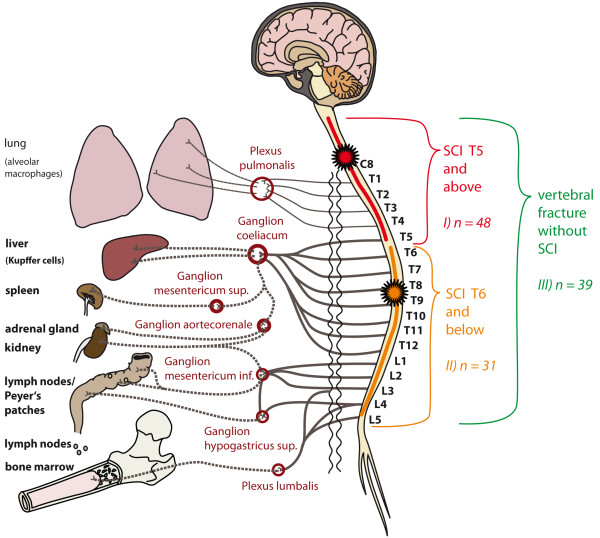
Relay-interaction of the immune system and the central nervous system. Legend: Groups for primary comparison in relation to the major sympathetic outflow (vegetative innervation). In Group I (SCI of the neurological level T4 or above) the lesion is localized within the spinal segments C2-T5, resulting in a disturbance of the sympathetic innervation of immunologically relevant organs through the coeliac ganglion and further ganglia connected through lower segments of the spinal cord. Of note, the neurological level is defined by the ISNCSCI as the most cranial segment with normal sensory function and a muscle grade of at least 3/5 with normal function in the segments above on both sides of the body, i.e. in case of a neurological level T4, the lesion begins in the segment T5. In Group II (SCI of the neurological level T5 or below) the lesion is located in the spinal segment T6 or below. Thus, the sympathetic outflow to the coeliac ganglion is expected being only partially disrupted or completely preserved. Group III consists of patients with vertebral fracture alone without injury to the spinal cord (control). Here, the sympathetic innervation is intact.